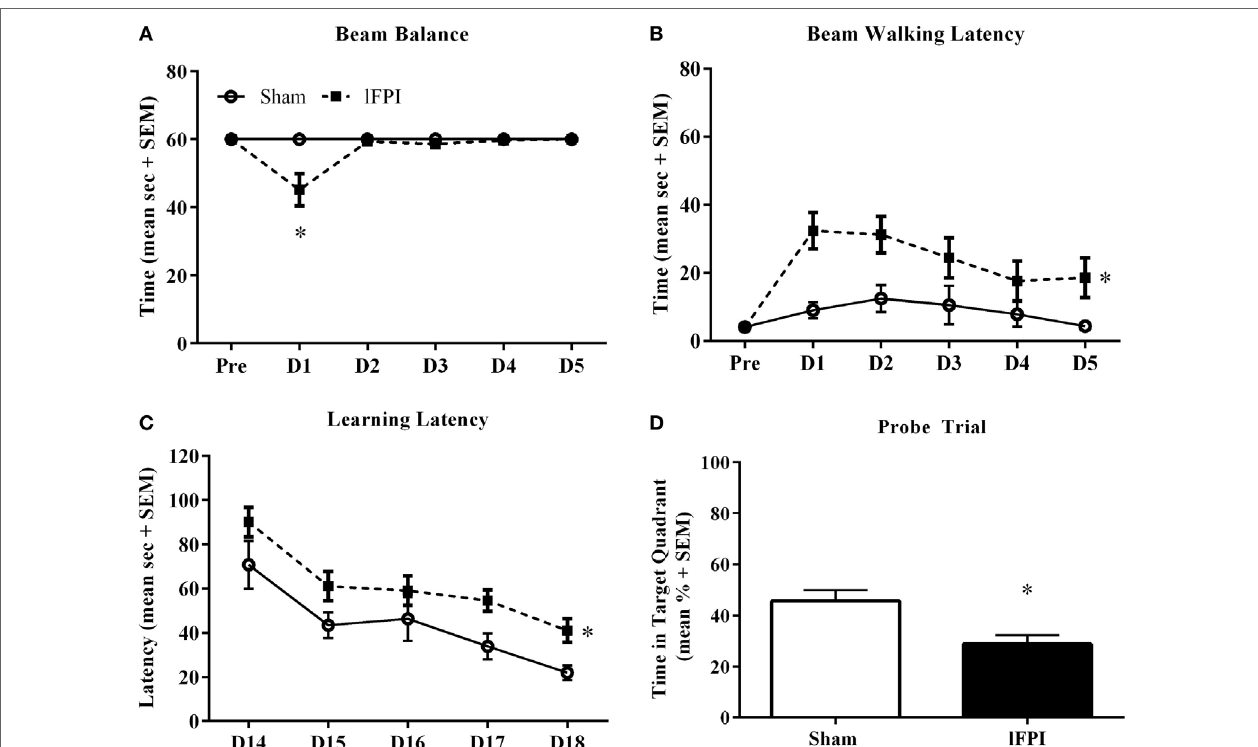
FigUre 1 | Lateral fluid percussion injury (lFPI) impairs motor and cognitive function. (a) Assessment of vestibulomotor function using the beam balance and beam walking tasks on days 1–5 post-injury, revealed lFPI produced a transient beam balance deficit at 1 day post-injury, compared with sham injury (* p <